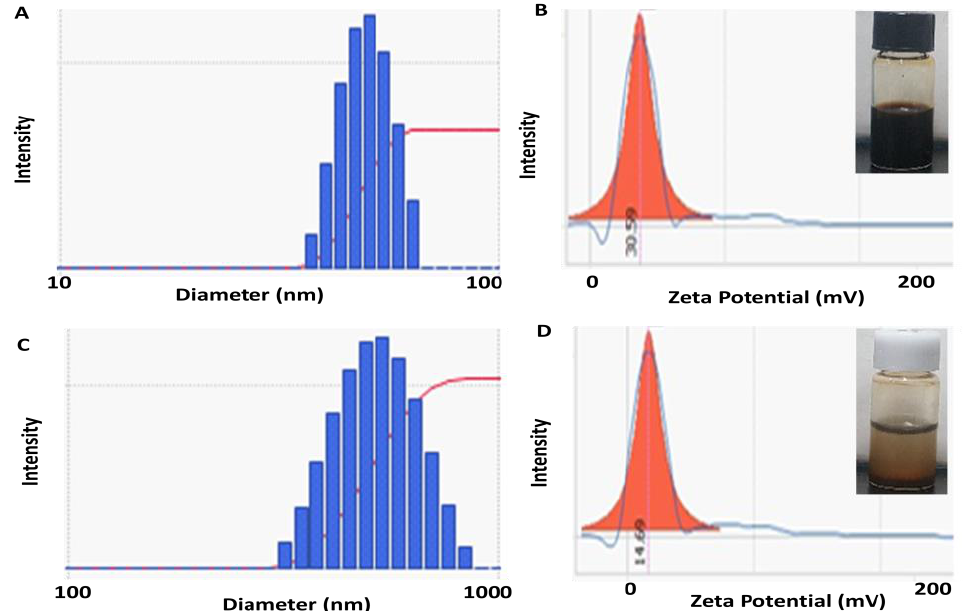
Figure 2. Dynamic light scattering (DLS) and zeta potential results for CF-MNPs ( A , B ) and ZCF-MNPs ( C , D ).